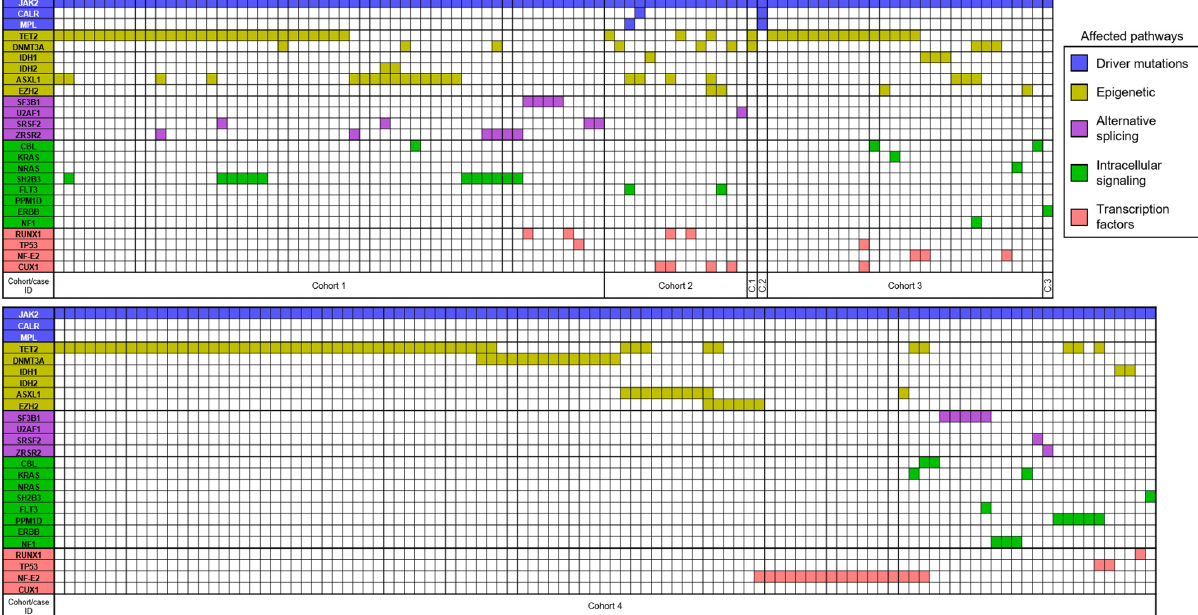
Figure 2. Graphical sum-up of 7 PV patients cohort/case reports (total = 205 patients). Each